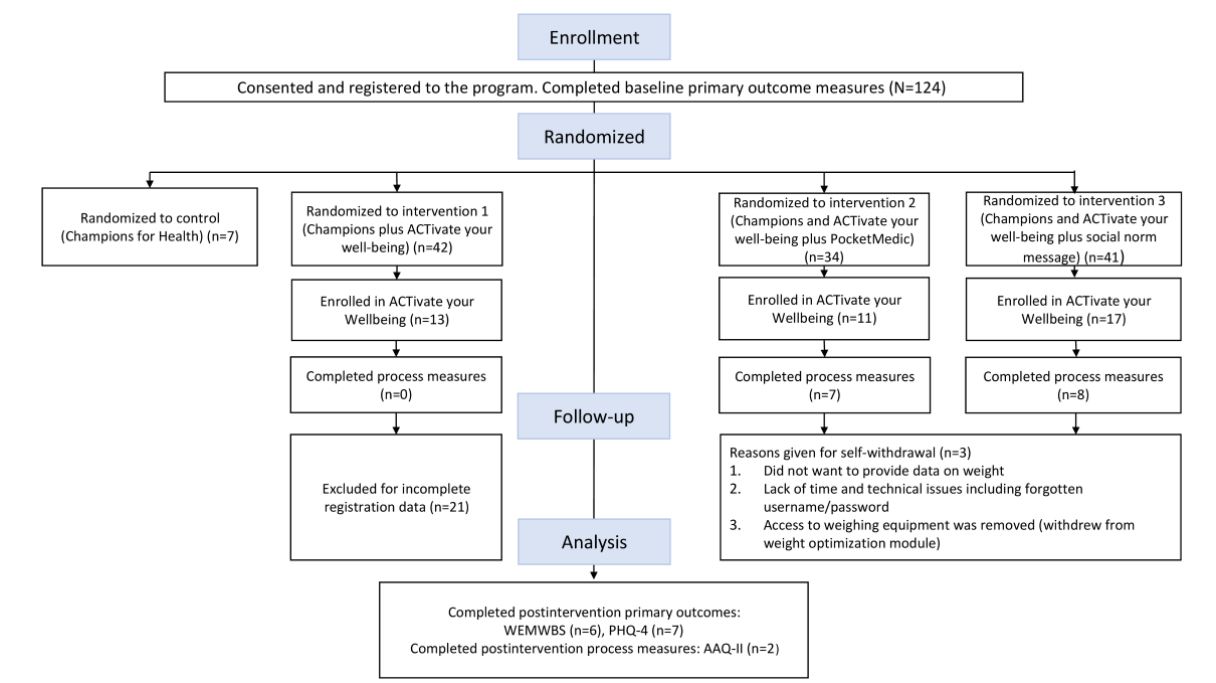
Figure 1. Consolidated Standards of Reporting Trials flow diagram. AAQ-II: Acceptance and Action Questionnaire—Revised; PHQ-4: Patient Health Questionnaire-4; WEMWBS: Warwick-Edinburgh Mental Well-Being Scale.